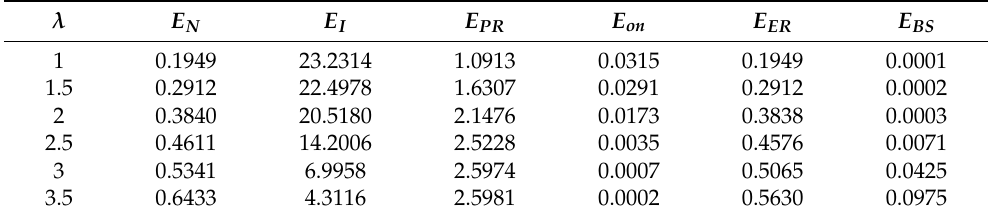
Table 1. Effect of λ for ( S , s , c , δ , µ , η ) = ( 35,12,5,0.8,7,2.6 )